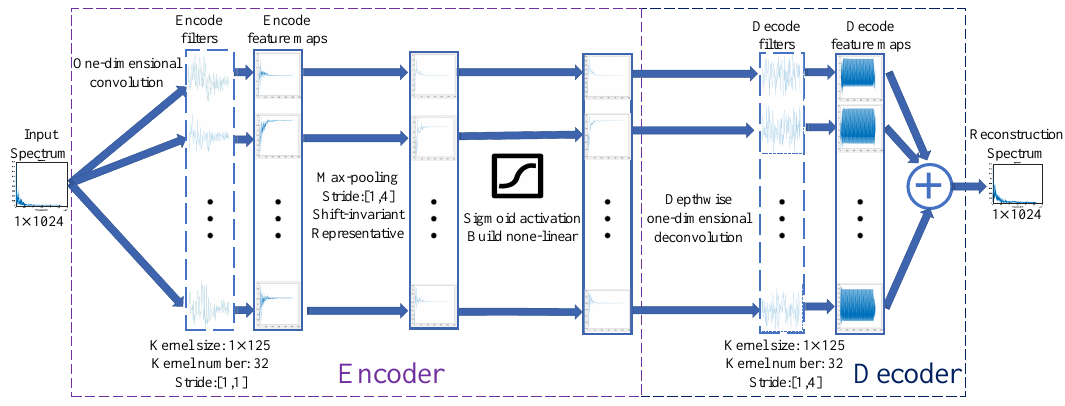
Figure 2. The first layer of the